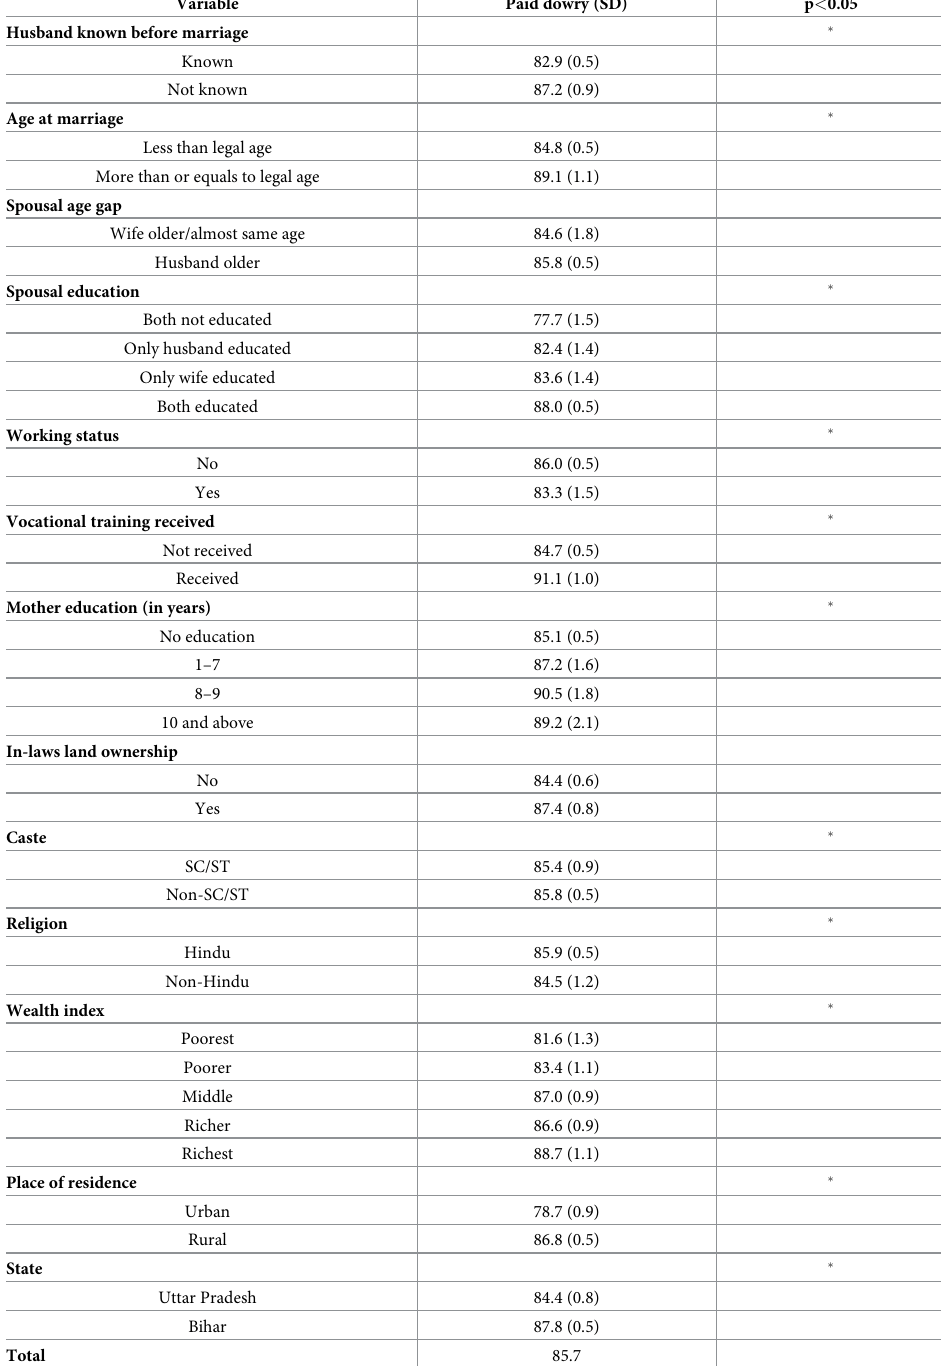
Table 2. Percentage distribution of adolescents who paid dowry by background characteristics, 15–19